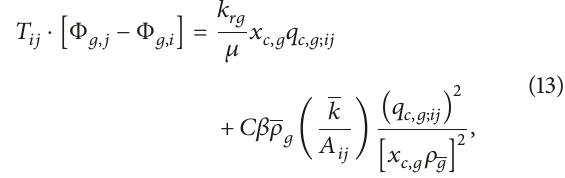
Figure 1: Numerical model of the shale gas reservoir.